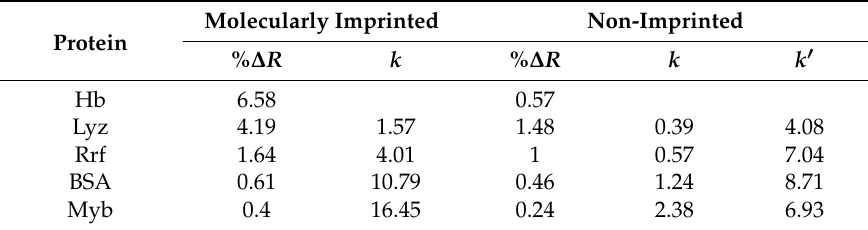
Figure 4. The real-time responses of the non-imprinted and molecularly imprinted nanofilm on-chips in a single protein solution ( A ) and protein mixture solutions ( B ). Table 2. The selectivity and relative selectivity coefficients of non-imprinted and molecularly imprinted nanofilm on-chips.